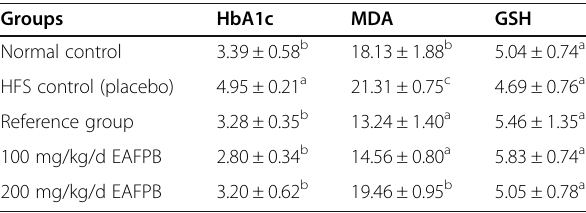
Data represent mean±SD ( n =5); values with dissimilar alphabets as superscripts are significant at p